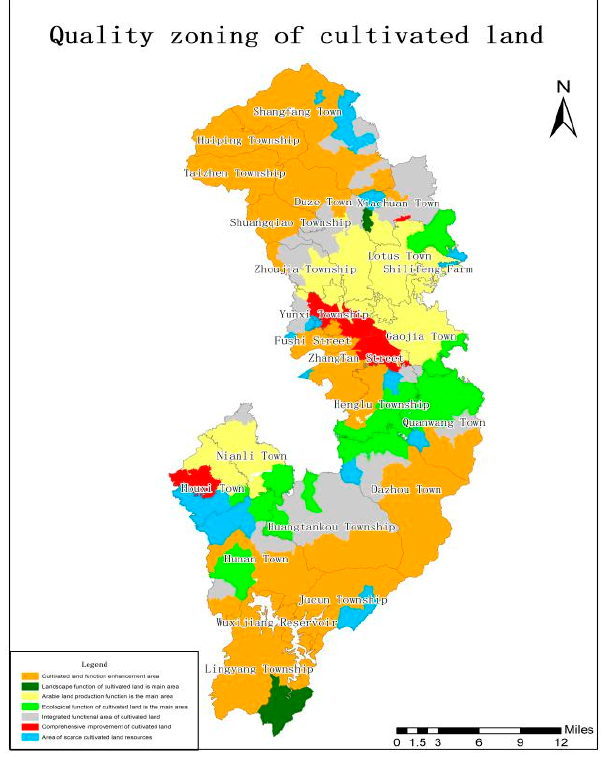
Figure 7. Quality zoning of cultivated land in Qujiang District.